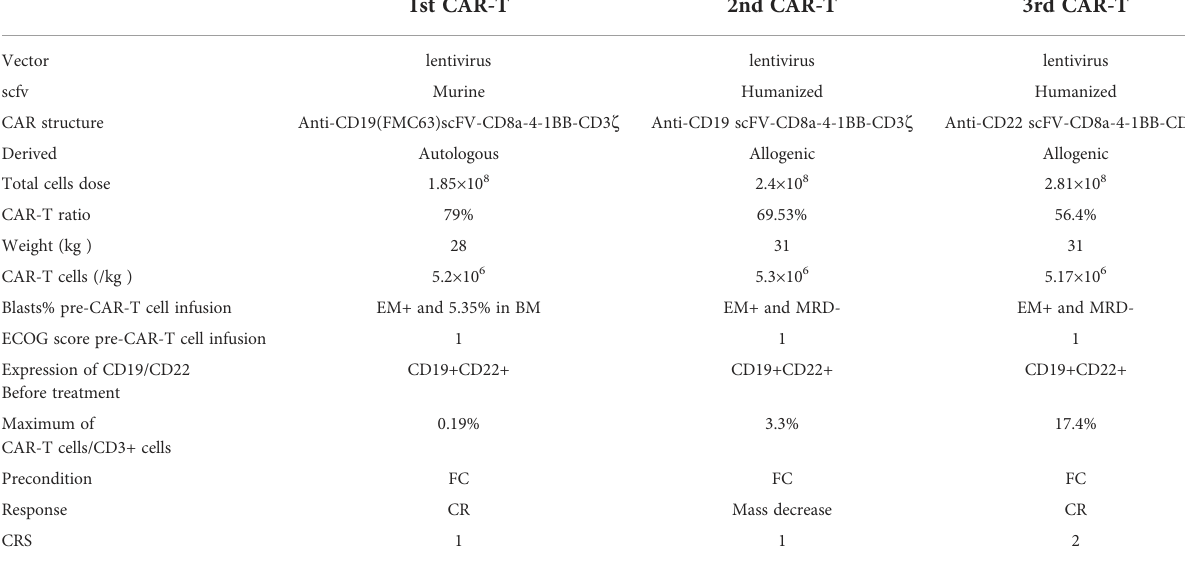
TABLE 1 Characterization of the three infusions of CAR-T